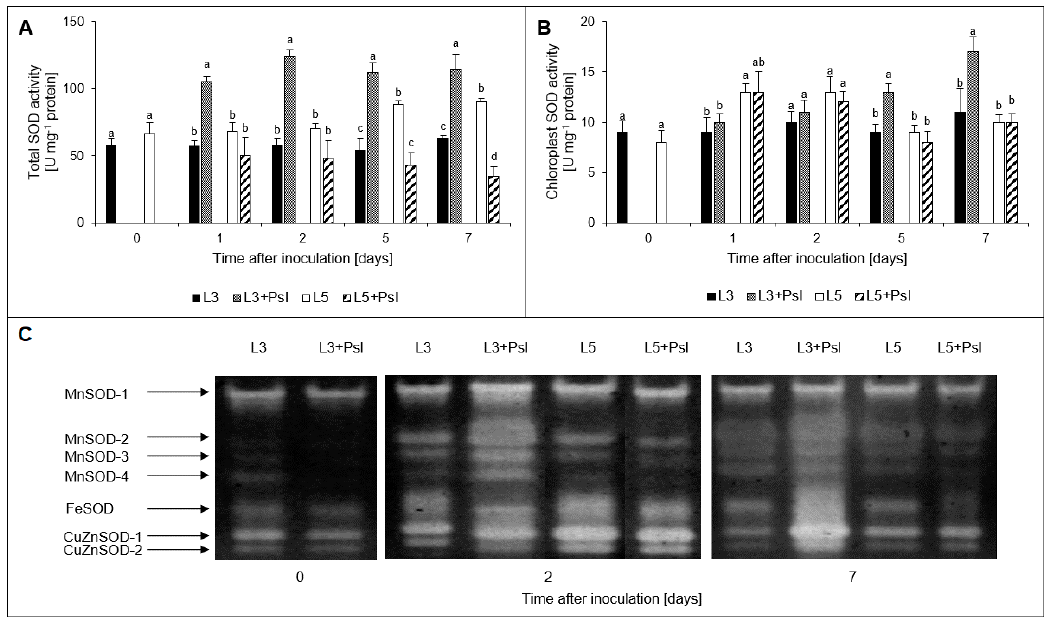
Figure 4. Superoxide dismutase (SOD) activity: ( A ) total SOD activity; ( B ) chloroplast SOD activity; ( C ) SOD isoforms electrophoregram. Values are means of four replicates (±SD). Different letters (a – b) indicate significant ( p ≤ 0.05) differences between experimental variants within a given time point.